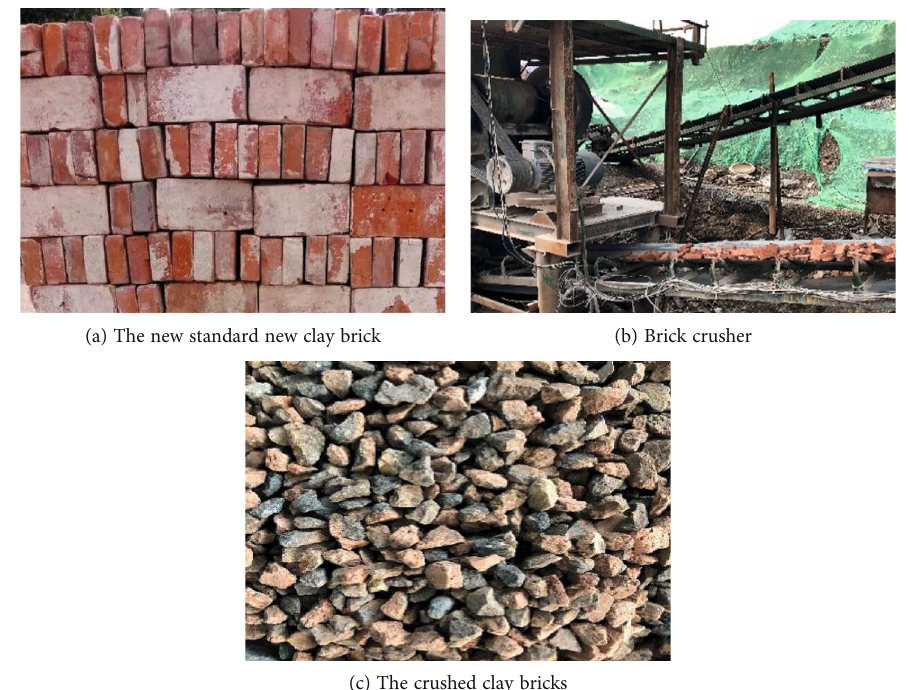
Figure 1: The crushed clay brick aggregates used in the tests.